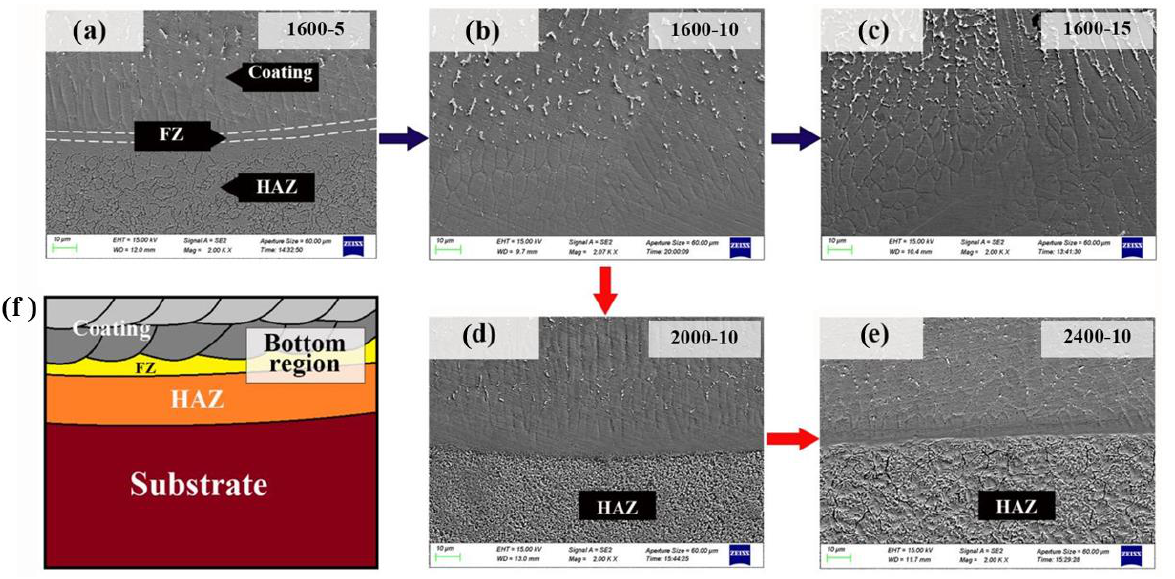
Figure 6. Microstructural evolution in the bottom region of laser cladding IN718 coating under different process parameters ( f ): Scanning speed increased from 5 mm/s to 15 mm/s (blue route ( a – c ), and laser power increased from 1600 W to 2400 W (red routes ( b , d , e )).